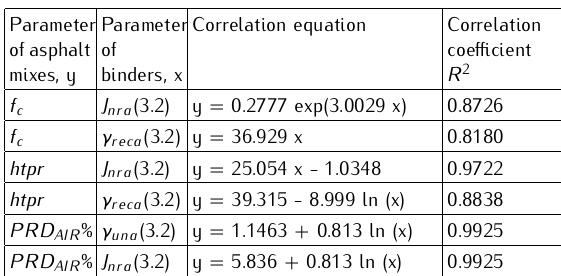
Table 4. Summary of the correlation equations between the perfor- mance parameters of different binders and AC 16 asphalt